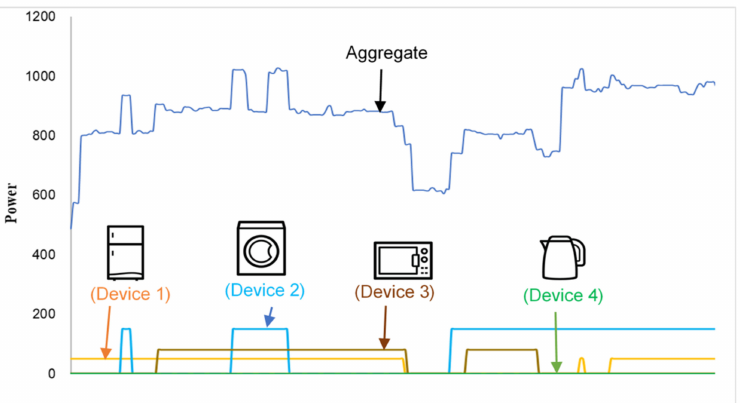
Figure 1. Concept of aggregate load profile and NILM. The task of NILM is to disaggregate the energy of each device and then identify it as shown in the colored plots.